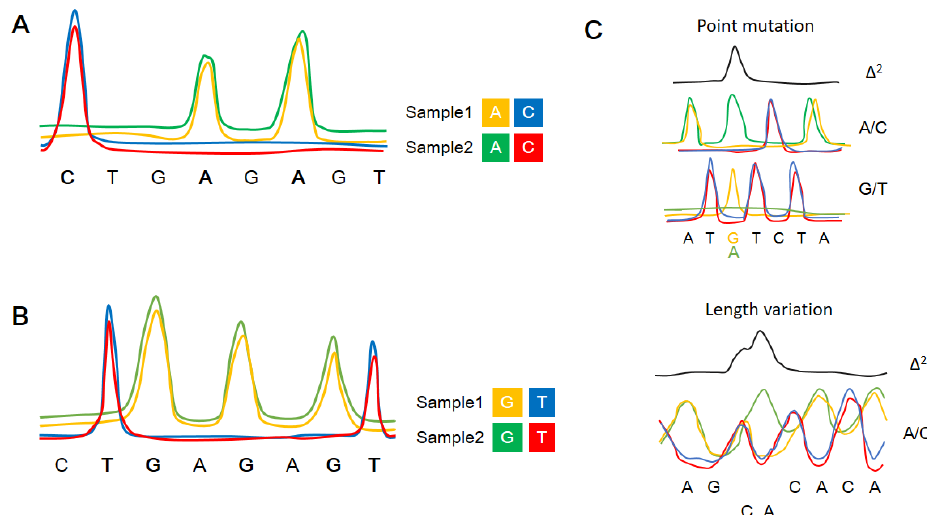
Figure 3. A schematic diagram of polymorphism ratio sequencing (PRS). ( A , B ) present the four-color